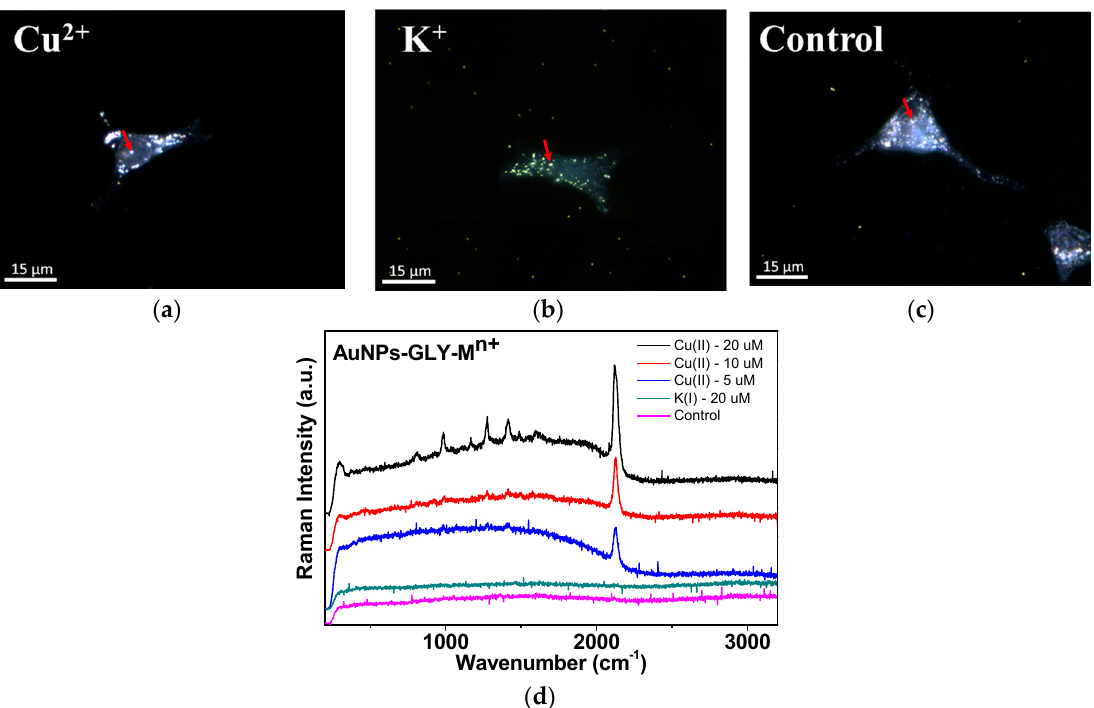
Figure 7. DFM cell images of HeLa cells treated with AuNPs-GLY-Cu 2+ (20 µM) ( a ); AuNPs-GLY-K + (20 µM) ( b ); and AuNPs-GLY ( c ) for 24 h and subsequently the SERS spectra were observed. Only Cu 2+ treated cells achieved the CN peak ( d ). The red arrows indicated the positions where the SERS spectra were taken.